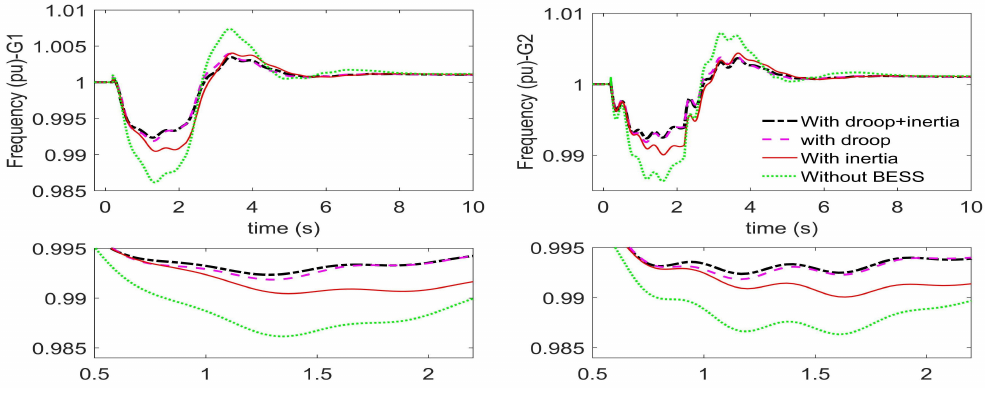
Figure 10. The frequency (pu) oscillation of generators with the generation event. Table 2. The frequency results of G1 with the load event.